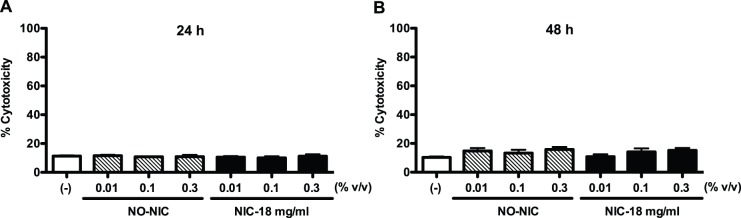
The physiological doses of e-liquid do not decrease primary human airway epithelial cell viability.Normal human tracheobronchial epithelial cells from young healthy non-smokers were treated with medium (control), e-liquid at various concentrations without nicotine (NO-NIC) or with 18 mg/ml of nicotine (NIC-18 mg/ml) for 24 h (A) and 48 h (B). Cell toxicity was assessed by measuring lactate dehydrogenase (LDH) levels in cell culture supernatants. Data (n = 4) are presented as mean ± SEM.